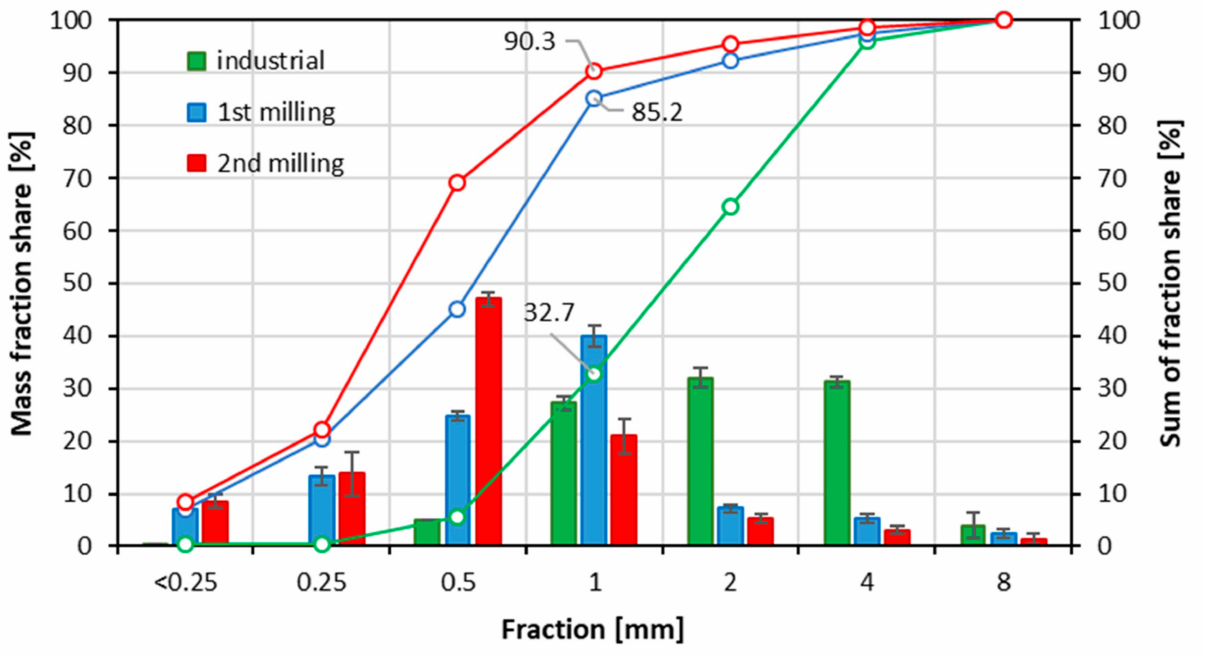
Figure 2. Mass fraction share of the particles used in